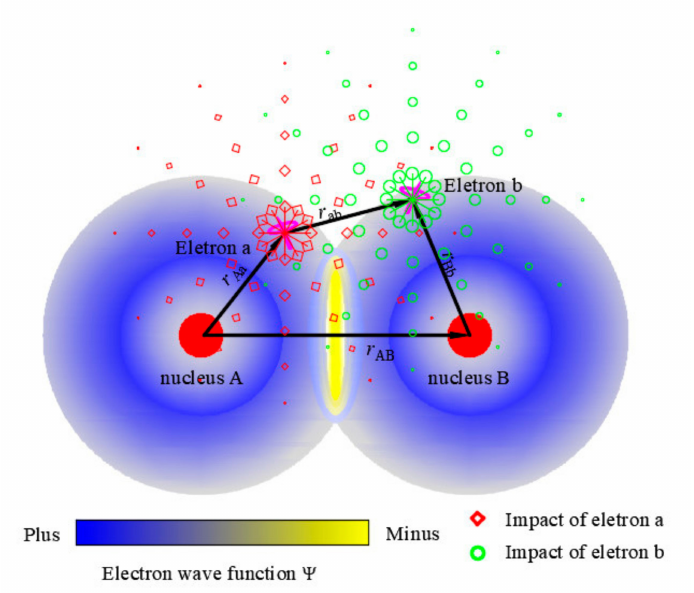
Figure 1. Primary mechanism of the interactions between atoms (A and B) and electrons (a and